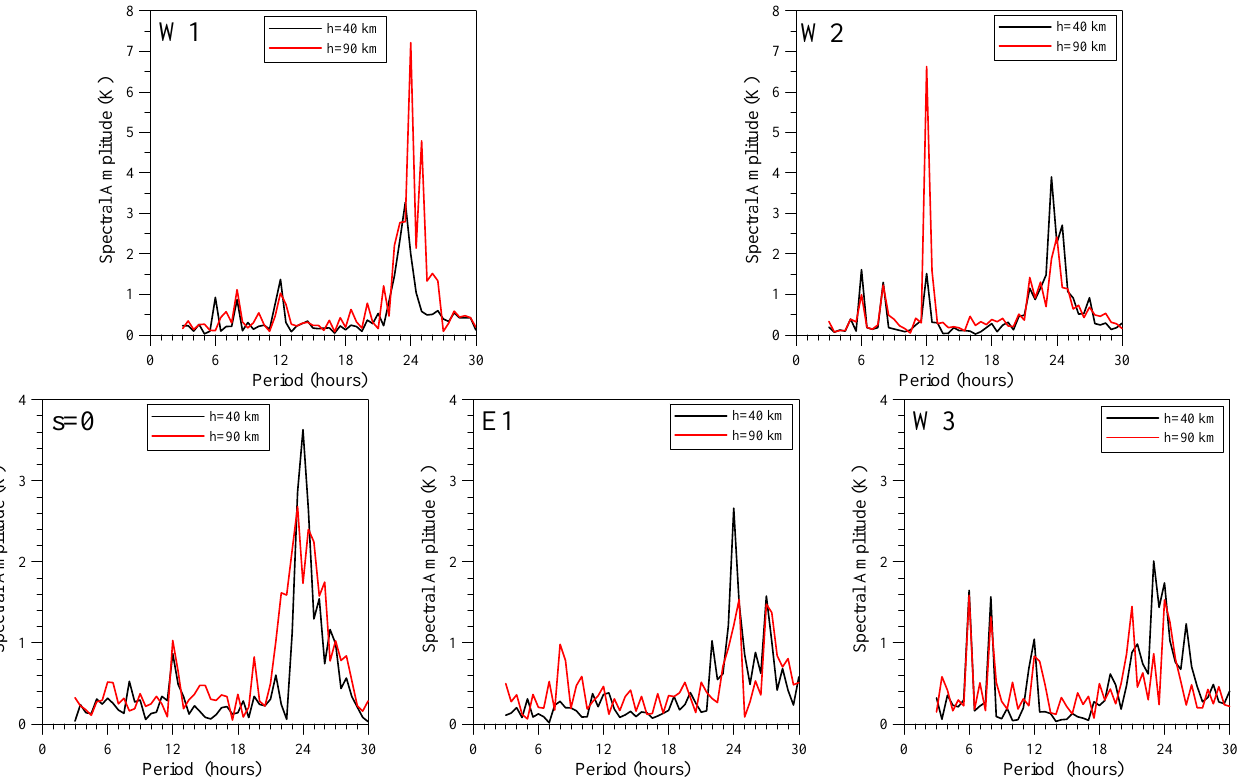
Fig. 2b. Two-dimensional Long-Scargle amplitude spectra calculated from the SABER data for December–January in the period range 3– 30h and for latitude 40 ◦ N and altitudes 40km (black color) and 90km (red color). The spectra presented in the upper row of plots are for the westward propagating tides with zonal wavenumber 1 (W1) and 2 (W2), while those in the bottom row of plots are: the zonally symmetric ( s =0) tides (left plot), eastward propagating tides with zonal wavenumber 1 (E1) (middle plot), and westward propagating tides with zonal wavenumber 3 (W3) (right